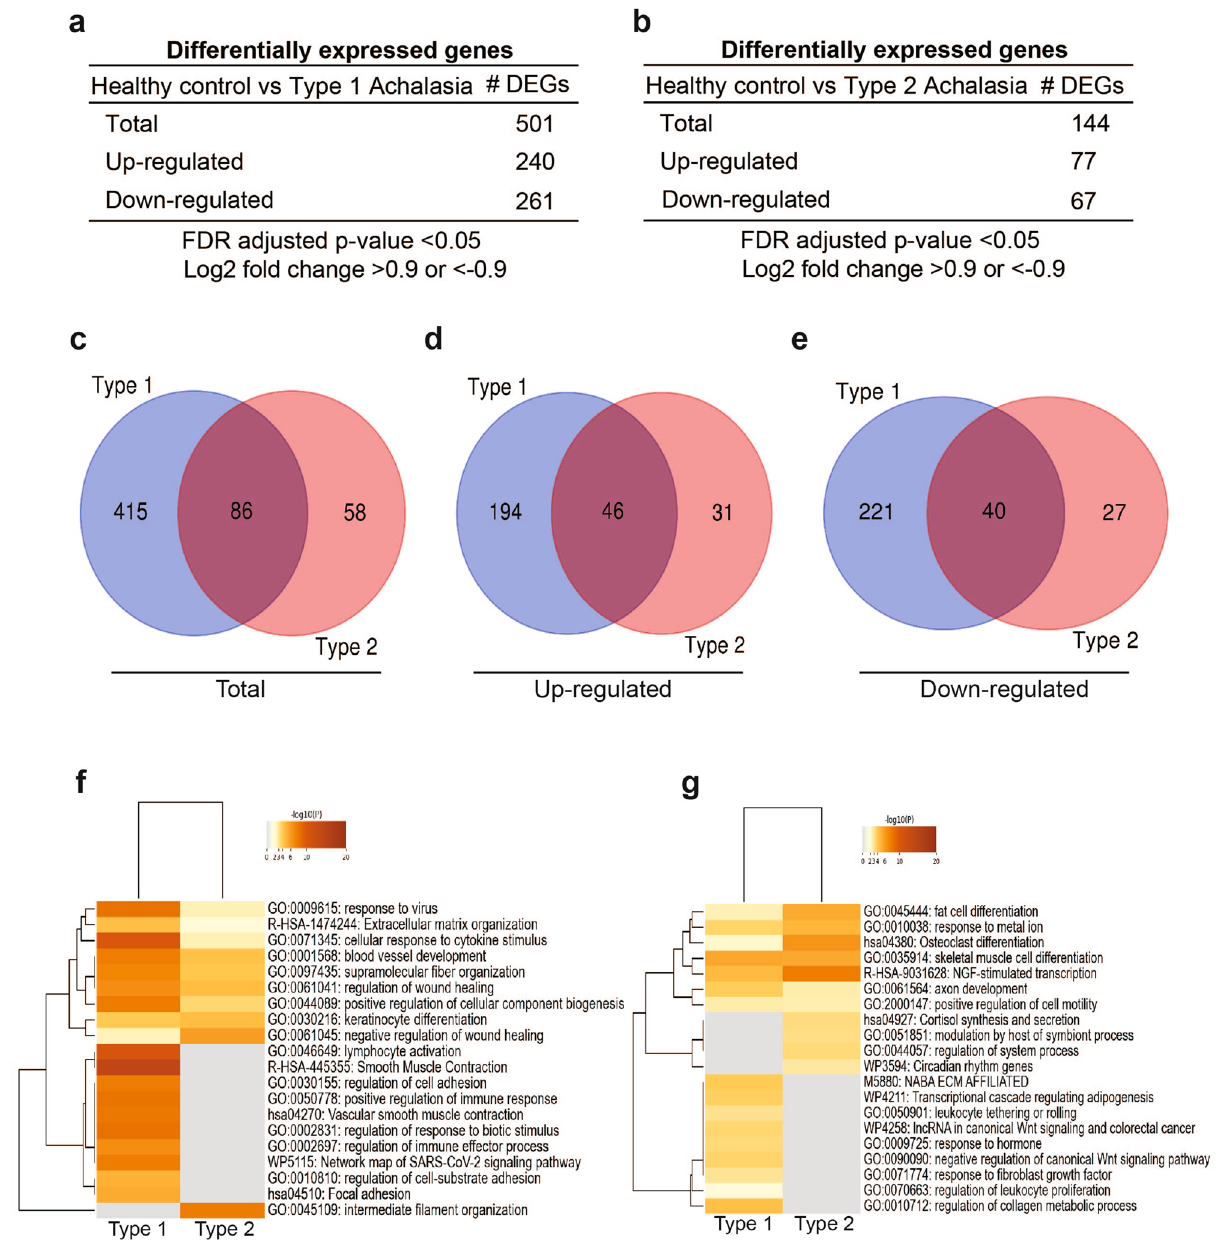
Figure 7. Differential gene expression analysis comparing changes in distal esophageal mucosa of type I and/ or type II achalasia versus controls. ( a ) The number of differentially expressed genes (DEGs) in type I achalasia versus heathy controls based on a log2 fold change of 0.9 and FDR < 0.05. ( b ) Differentially expressed genes between type II achalasia and healthy controls were selected based on a log2 fold change of 0.9 and FDR < 0.05. ( c ) Venn diagram showing overlap of total DEGs in type I and type II achalasia subjects. ( d ) Venn diagram showing overlap of up-regulated DEGs between type I and type II achalasia subjects. ( e ) The overlap of